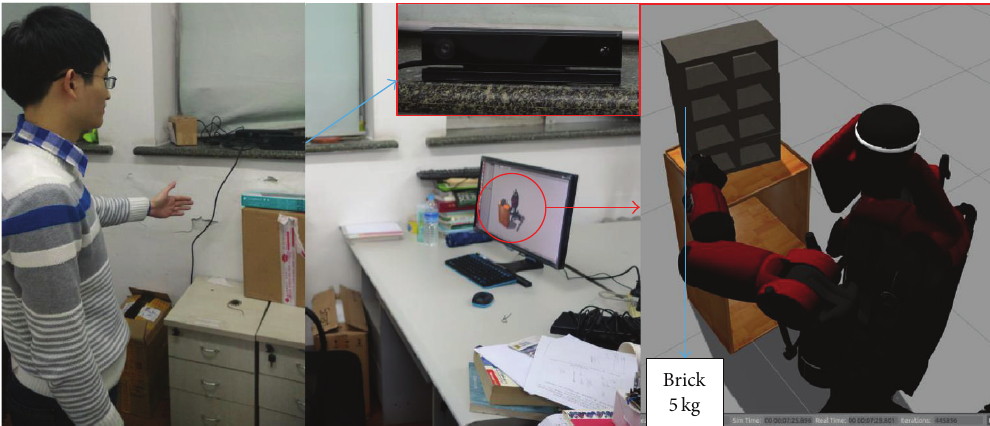
Figure 10: Experimental setup for human and Baxter robot collaboration intuitively and compliantly in teleoperation scenario. The virtual Baxter robot environment is based on ROS and gazebo [58]. Four bricks are put on the shelf and their total weights are modified to 5 kg. Baxter robot is supposed to move the four bricks with different arm configurations.